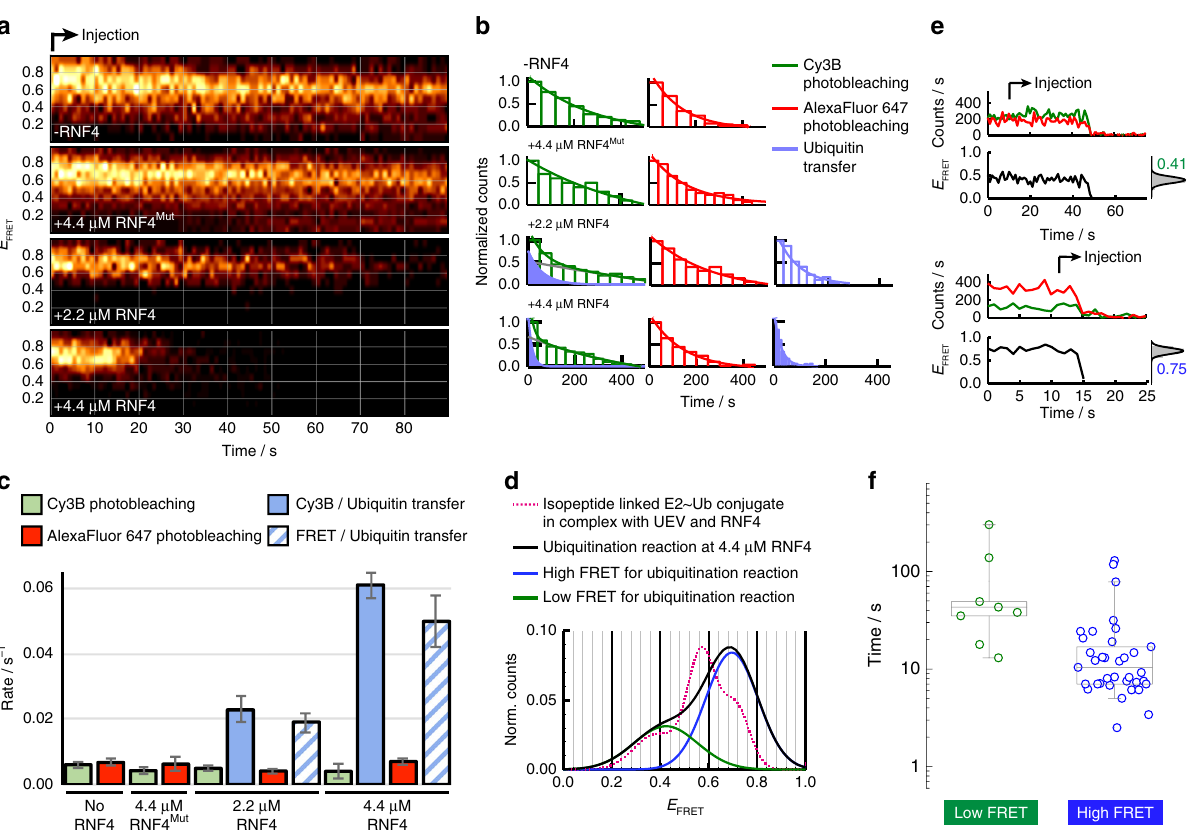
Fig. 5 RNF4 catalyses ubiquitin transfer from a closed conformation. a Single molecule contour plots showing the progression of the FRET trajectory following the real-time injection of reactants at the indicated experimental conditions and concentrations. Mut denotes the RNF4 RING domain dimer containing E2~Ub binding site mutations (M140A and R181A). b smFRET dwell-time histograms obtained for Cy3B photobleaching (green, left panel), fast Cy3B loss (blue, left panel), AlexaFluor 647 photobleaching (red, middle panel) and FRET loss events (blue, right panel). The solid lines represent the fi t to single exponential decay functions. c Comparison of the rates of Cy3B (green) and AlexaFluor 647 (red) photobleaching and ubiquitin transfer, obtained by fi tting the dwell-time histograms in b to mono- or biexponential decay functions. Ubiquitin transfer is split into the rate of loss of the FRET signal (blue stripe) and the loss of Cy3B signal from molecules containing Cy3B only (solid blue). Error bars represent the standard error of the rate extracted from non- linear least squares fi tting of the histograms in b . d Gaussian pro fi le of relative FRET populations for the stable isopeptide linked conjugate (magenta dotted line) and the real-time ubiquitination reaction. The histograms were omitted for clarity. e Representative traces for reactions from low (top) and high (bottom) FRET states. Injection start time is indicated along with corresponding FRET histogram (grey). f Box-plot comparison of rate of reaction at 4.4 μ M RNF4 from the low (green circles, n = 8 molecules) and high FRET (blue circles, n = 36 molecules) states. The extremes, upper and lower quartiles of the distribution, and the median are represented by the whiskers, box and middle lines, respectively. Source data are provided as a Source Data fi that the reaction from the closed conformation is likely to be a universal mechanism for RING E3 catalysis.